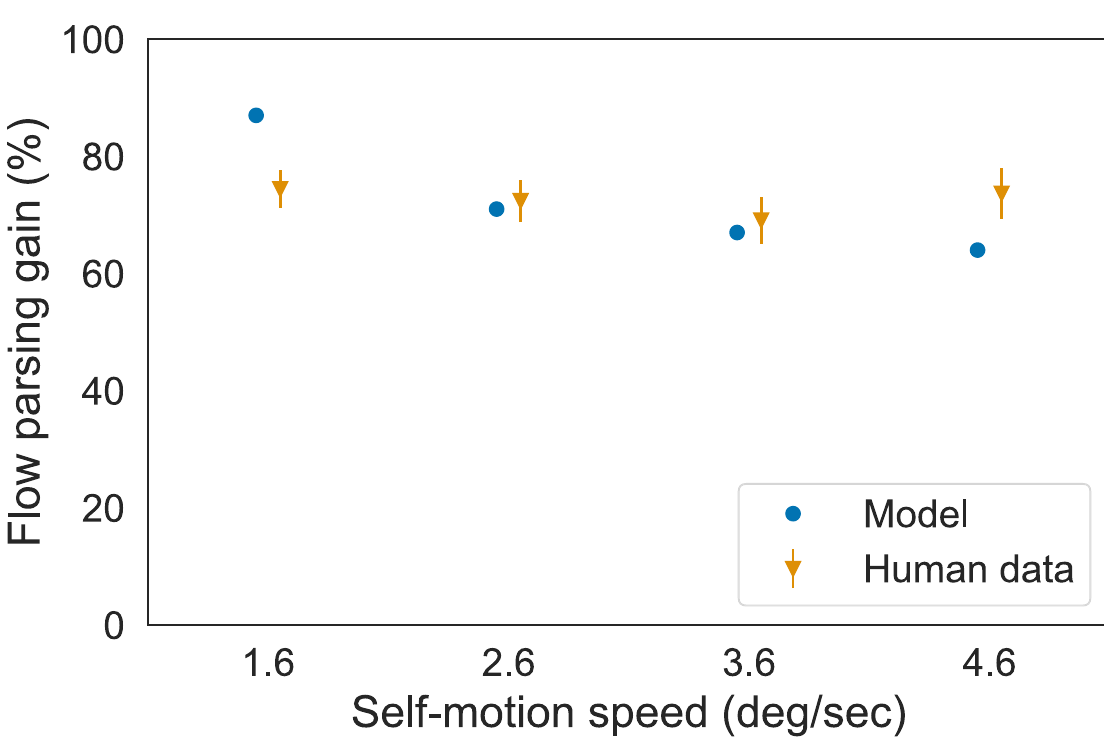
Fig 13. The flow parsing gain achieved by the model and the human observers for different self-motion speeds with stereo optic flow (Simulation 3). Error bars denote SEM.